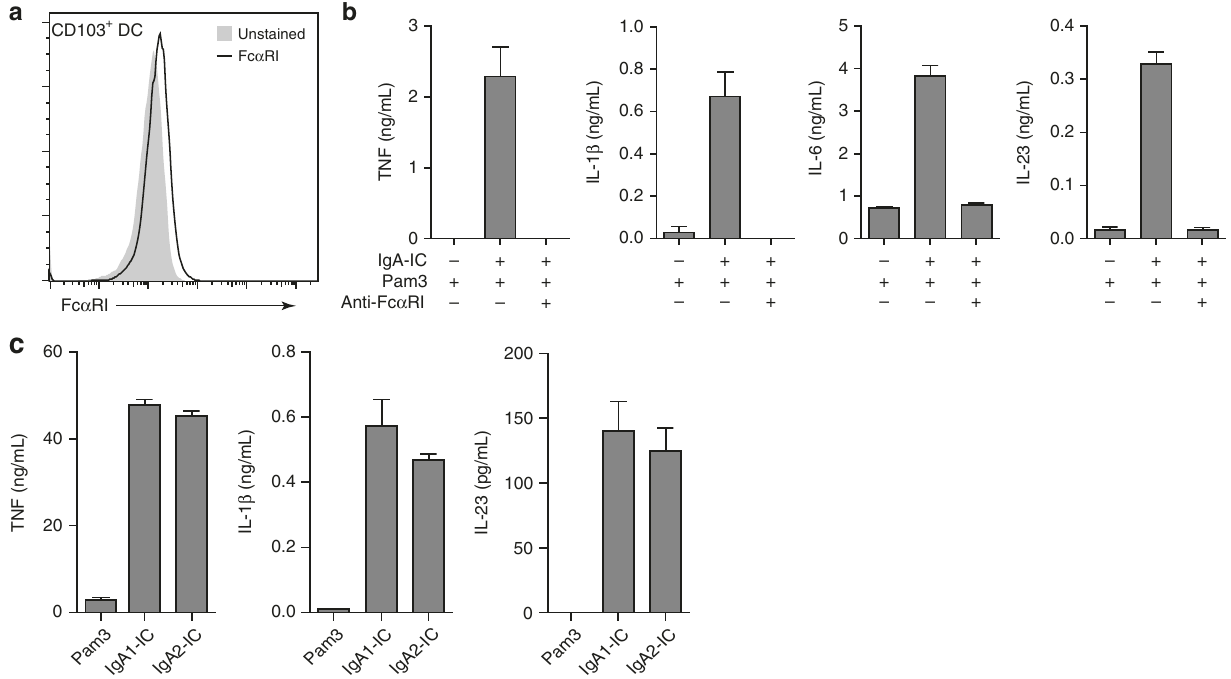
Fig. 3 Complexed IgA1 and IgA2 amplify proin fl ammatory cytokine production through Fc α RI. a Fc α RI expression on unstimulated CD103 + dendritic cells (DC) was analysed using fl ow cytometry. Light grey histogram indicates background staining. b Prior to stimulation, CD103 + DCs were incubated with a blocking antibody against Fc α RI and stimulated with Pam3CSK4 (Pam3) alone or Pam3CSK4 together with IgA immune complexes (IgA-IC). c Cytokine production by CD103 + DCs stimulated with Pam3CSK4 alone or in combination with IgA1-IC or IgA2-IC. Experiments b and c were performed in triplicate. After 24 h cytokine levels were analysed using ELISA, mean + s.e.m. Representative example ( a – c ) of three experiments using different